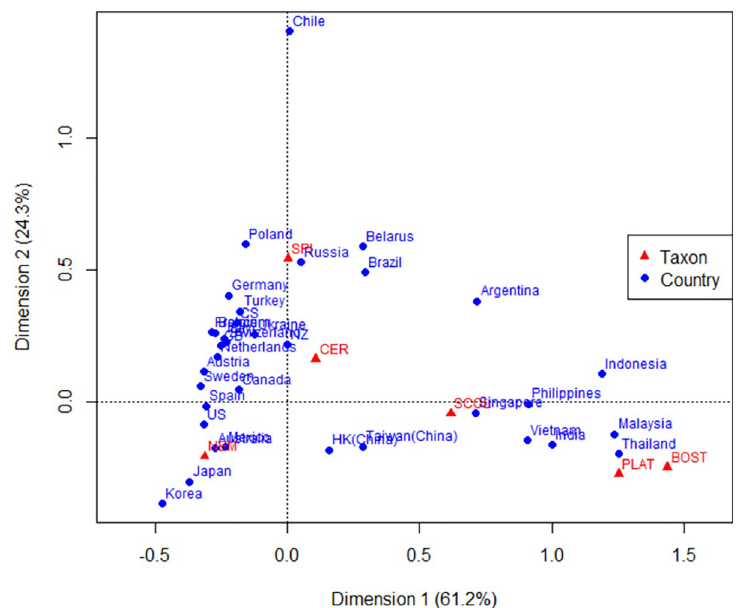
Fig 5. Correspondence analysis of major insects and nematodes intercepted on WPM in China with their source countries (regions).